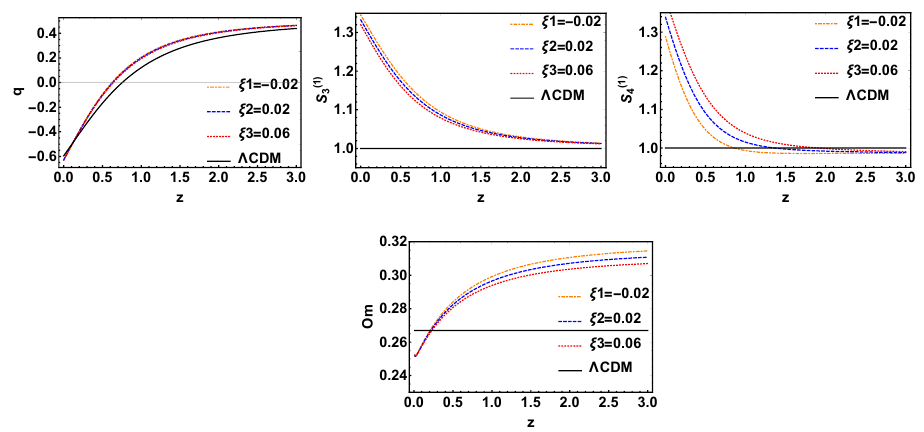
( 1 ) ( 1 ) , S and Om , respectively, versus red shift z for the 3 4